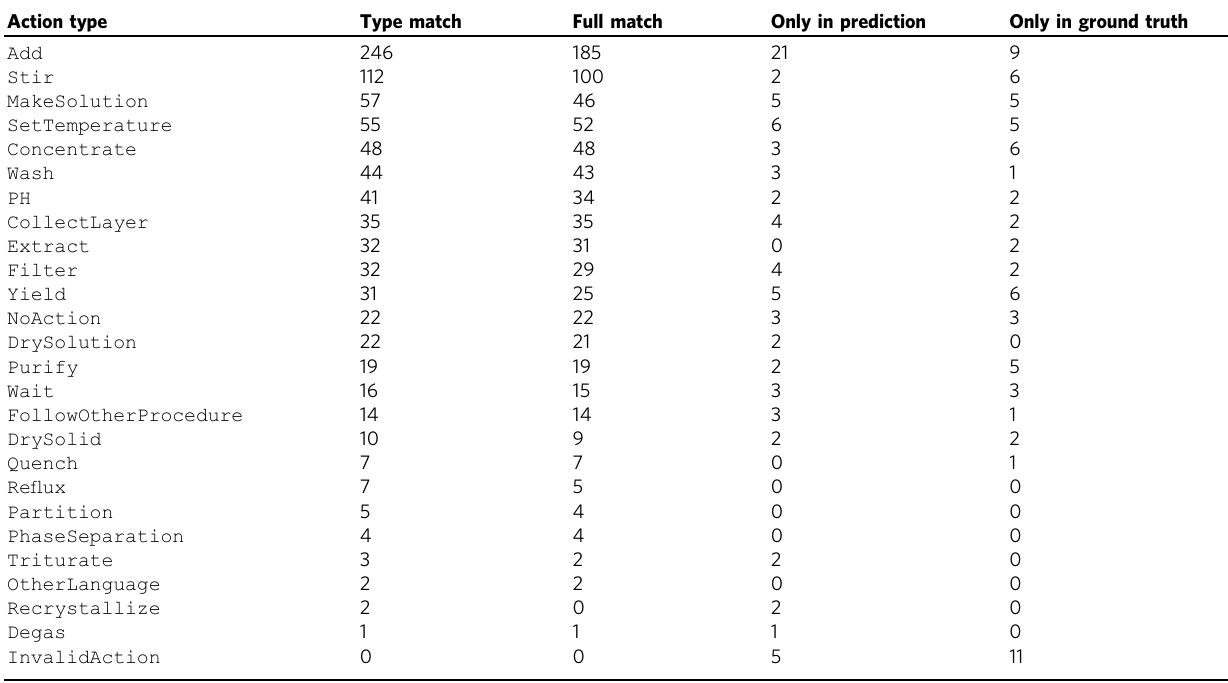
Table 5 Prediction accuracy by action